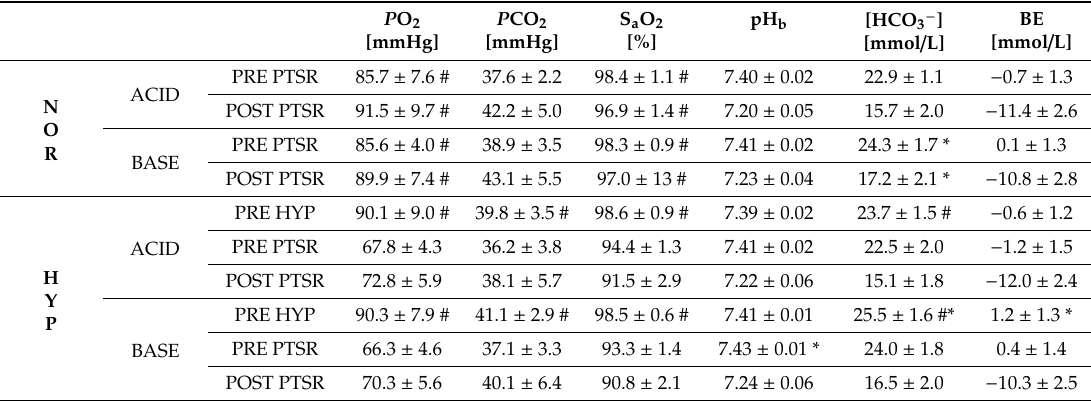
Table 1. Portable tethered sprint running test (PTSR)-related blood gas parameters after acidizing or alkalinizing diet under normoxic and hypoxic